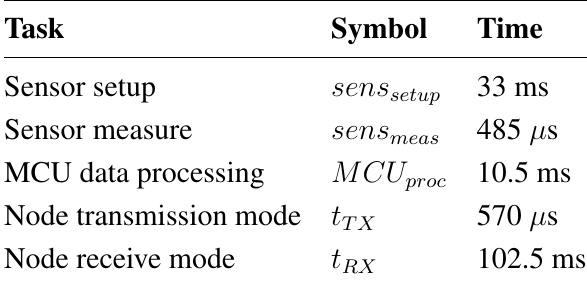
Table 1. Sensor states duration time. MCU, microcontroller.